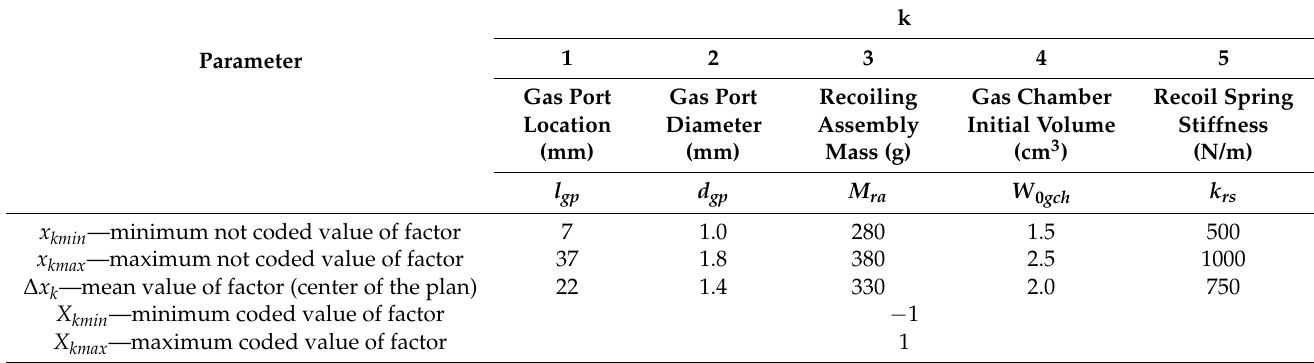
Table 4. The values of the